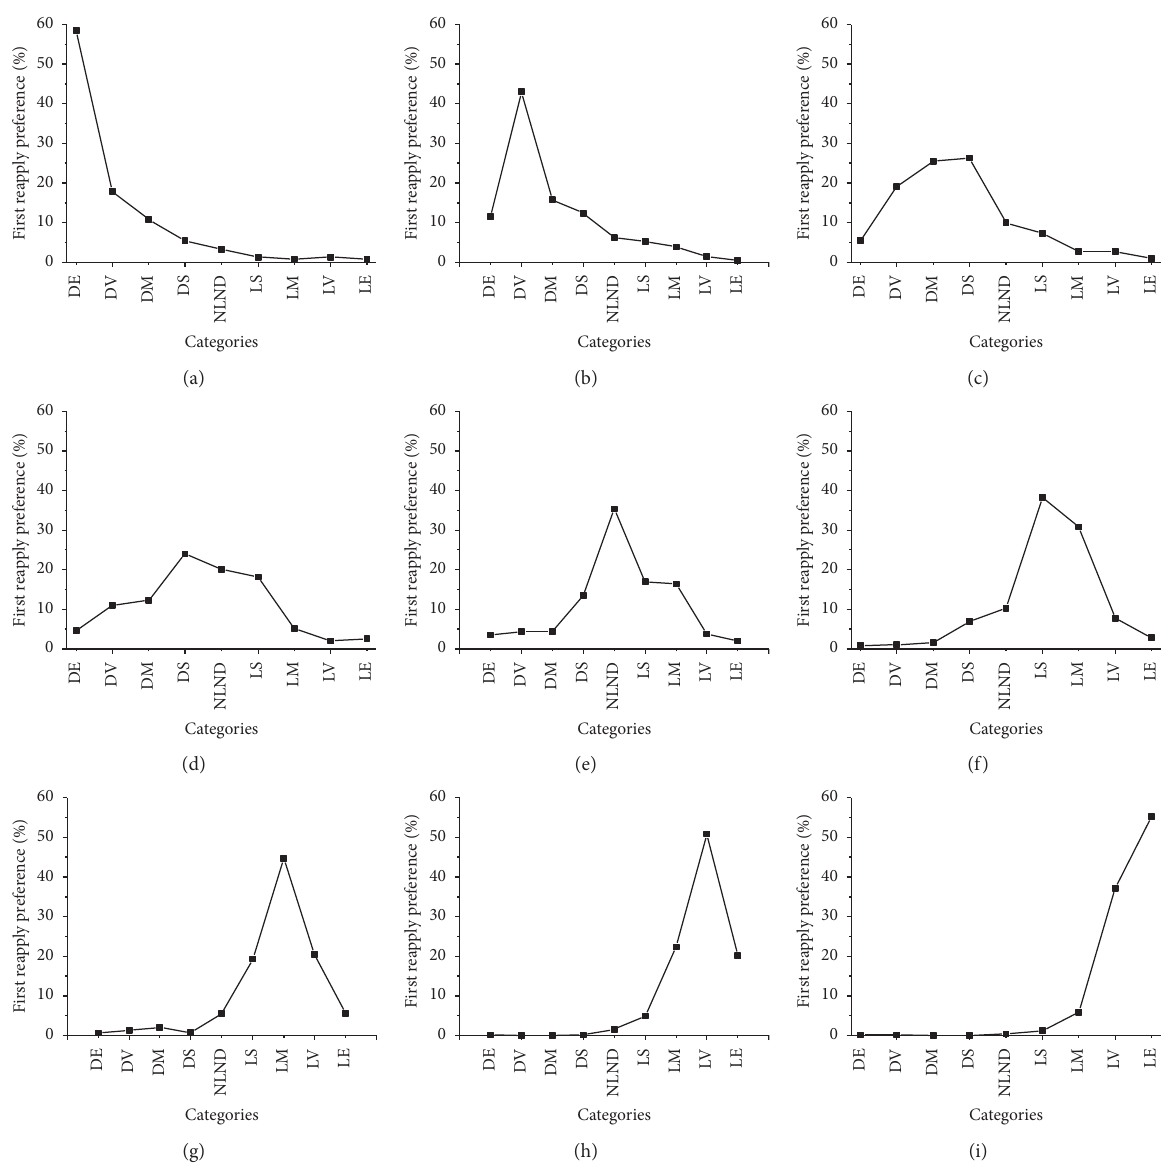
Figure 18: Mean variability of the responses of Experiment 1 compared to the responses of the second reapplication. (a) Preference in Experiment 1: dislike extremely. (b) Preference in Experiment 1: dislike very much. (c) Preference in Experiment 1: dislike moderately. (d) Preference in Experiment 1: dislike slightly. (e) Preference in Experiment 1: neither like nor dislike. (f) Preference in Experiment 1: like slightly. (g) Preference in Experiment 1: like moderately. (h) Preference in Experiment 1: like very much. (i) Preference in Experiment 1: like